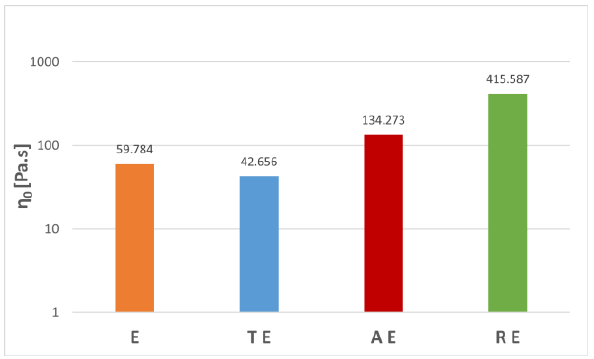
Figure 5. Comparison between the zero-shear viscosity values measured for the gel – creams E prepared with E at 0.7%, T E prepared with T at 0.2% w / w and E at 0.5% w / w , A E prepared with A at 0.2% w / w and E at 0.5% w / w , R E prepared with R at 0.2% w / w and E at 0.5% w / w .